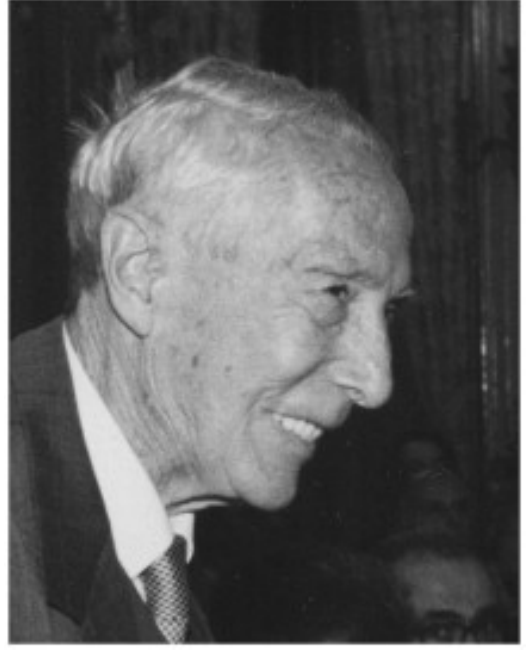
Figure 1. Doriano Cavallini